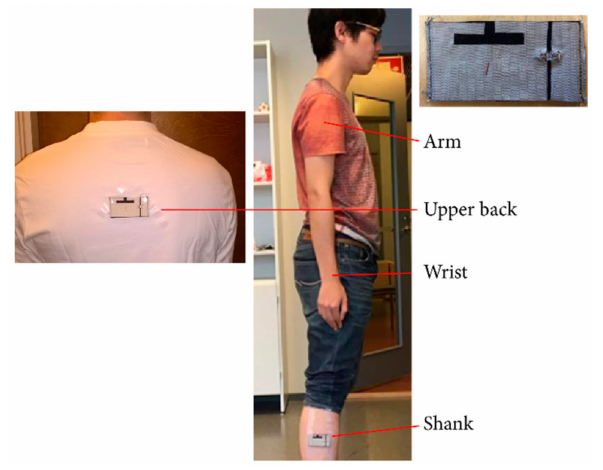
Figure 10. Implemented Antenna on Clothes